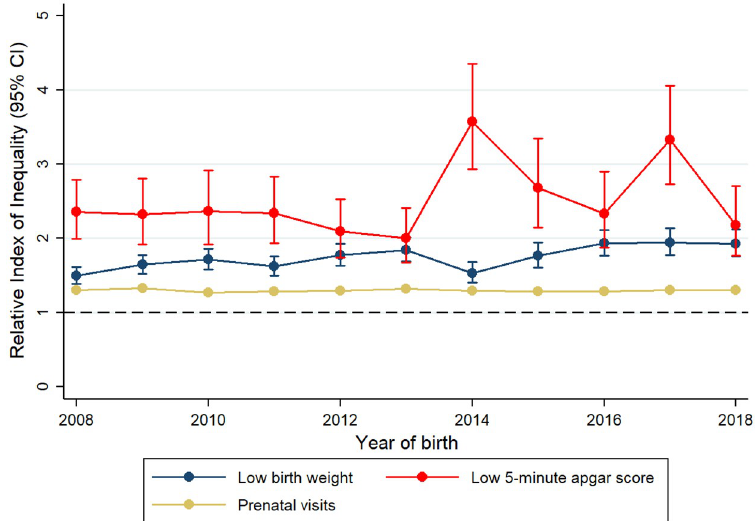
Fig 2. Changes in relative inequalities in birth outcomes and prenatal care by maternal education level from 2008 to 2018. level (SII: 14.11, 95% CI: 13.49, 14.73) and 10.8 percentage points higher among uninsured mothers (SII: 10.77, 95% CI: 10.19, 11.35) (Table 2). When comparing the magnitude of